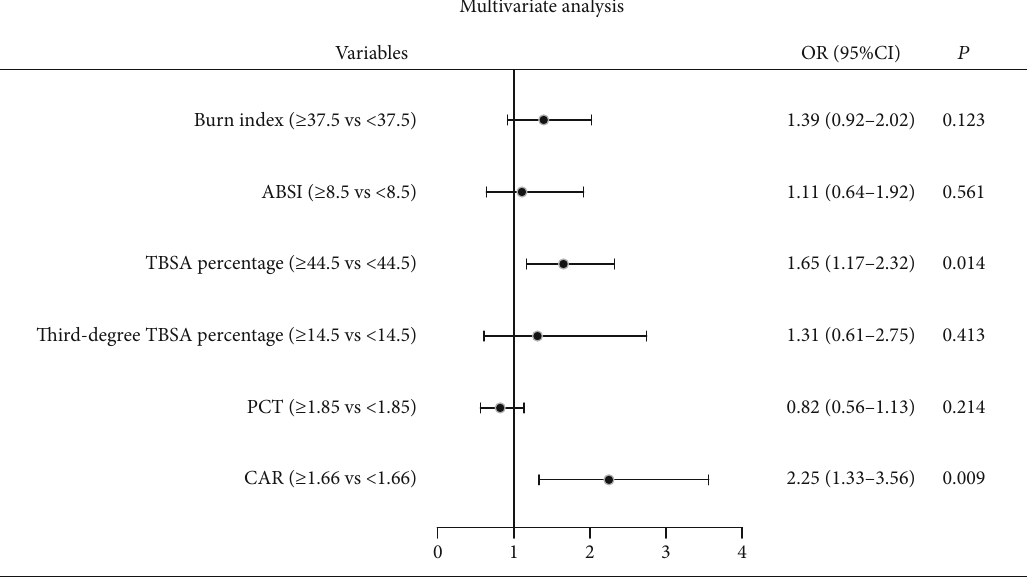
Burn index (≥37.5 vs <37.5)